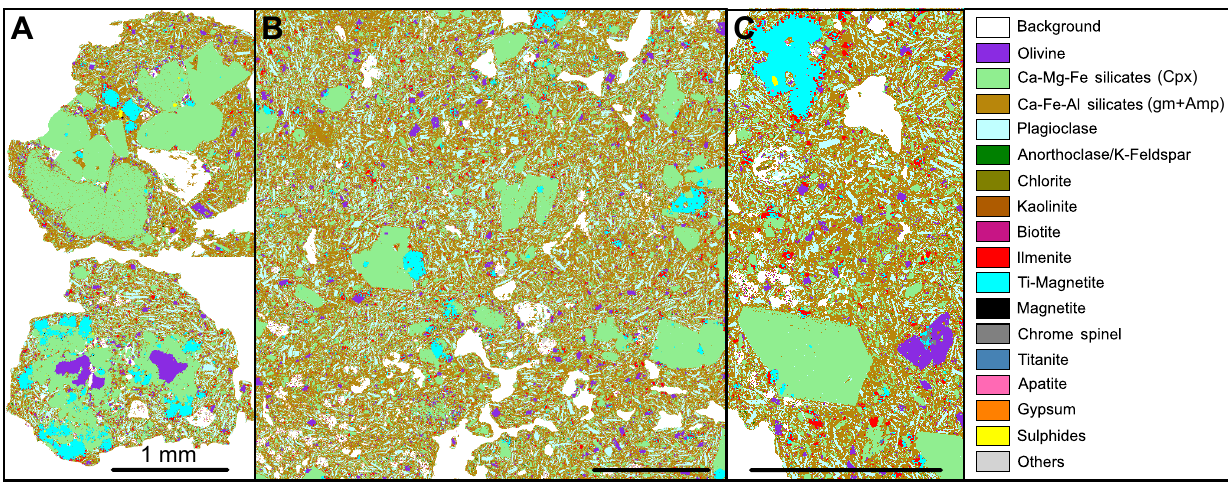
Figure 4: Lava CAN_LLP_0001 QEMSCAN ® maps illustrate and quantify crystal clusters with variable textures and Figure 4. Pankhurst et al. mineralogy [A] lava fragments containing crystal clusters with different textures and mineralogy, composed pri- (Two columns; 165 mm width x 95 mm height) marily of clinopyroxene ˘ Ti-magnetite ˘ olivine; [B] representative textures of vesicular porphyritic lava; [C] an area exemplifying contrasted morphologies between typical crystals of clinopyroxene, Ti-magnetite and olivine. Abbreviations: Cpx = clinopyroxene; Amp = amphibole, Ti-mag = titanomagnetite; gm =